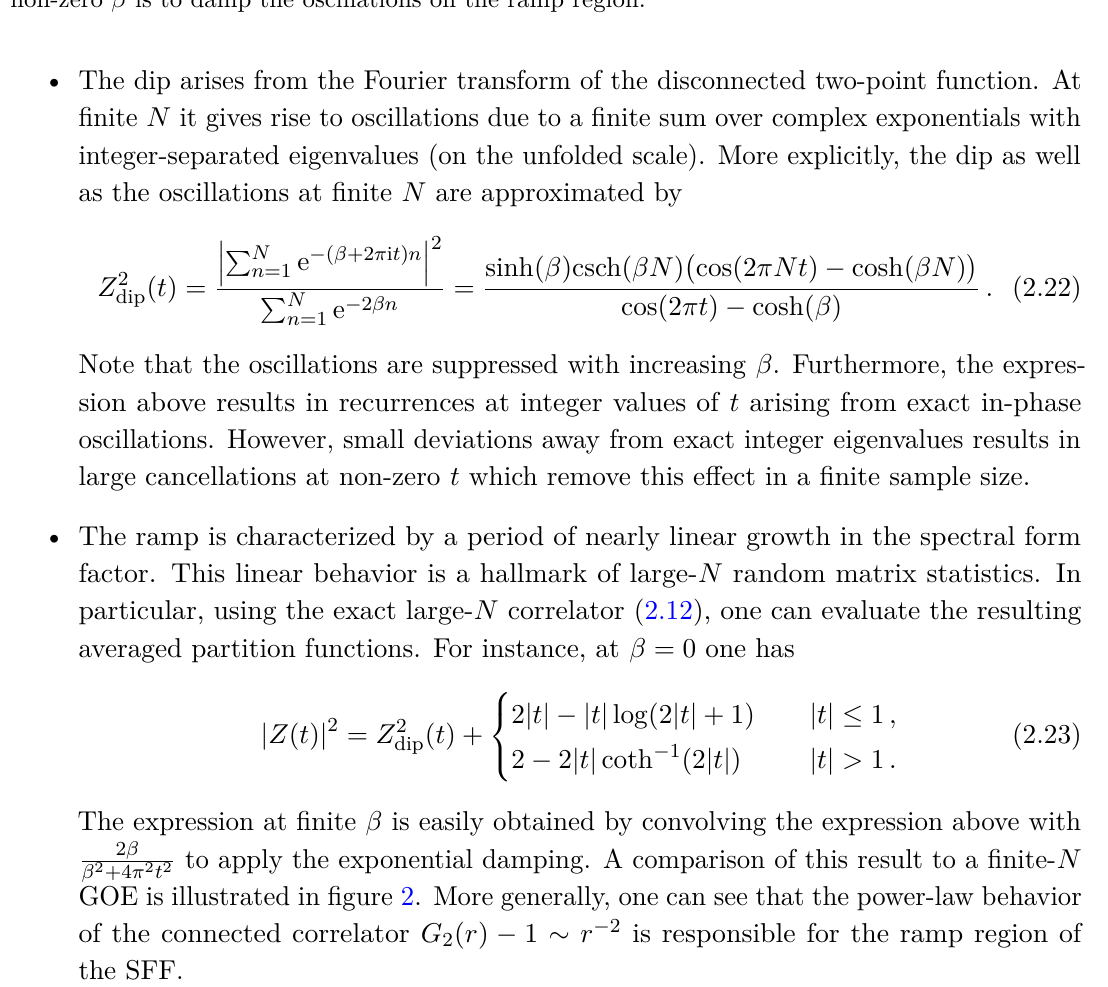
Figure 2 . Unfolded finite- N vs infinite- N GOE spectral form factors for β = 0 . The orange curve shows an ensemble average consisting of the eigenvalues of 100,000, 100 × 100 random symmetric matrices. After the dip, there is a period of approximately linear growth moderated by oscillations of decreasing amplitude, followed by a plateau. The β → 0 limit of equation (2.23) exactly matches the orange curve, so we have not plotted it separately. The blue curve shows the spectral form factor for N → ∞ and β → 0 as given by (2.23). Only the ramp and plateau are present. The effect of non-zero β is to damp the oscillations on the ramp